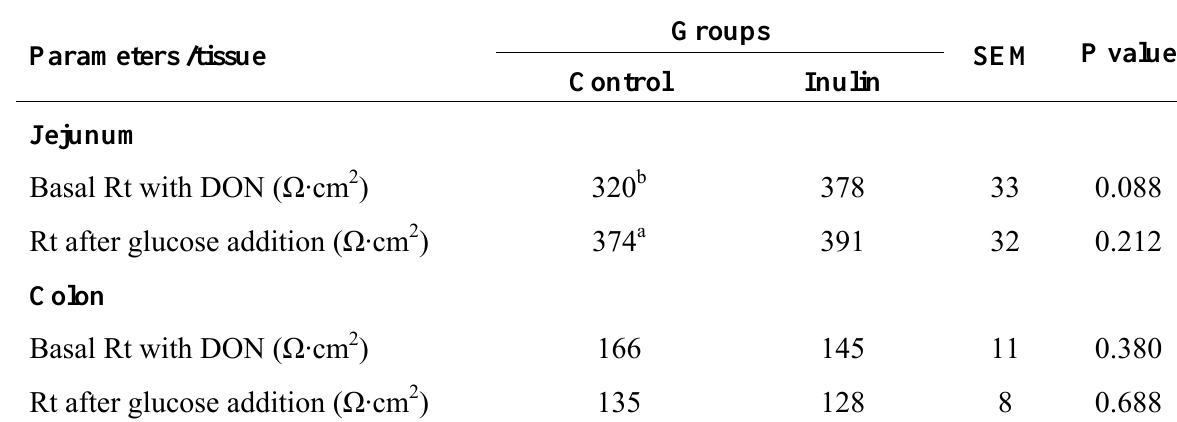
Table 5. The electrical tissue resistance (Rt) across the isolated jejunal and colonic mucosa of broilers after preincubation of the tissues with DON and after glucose